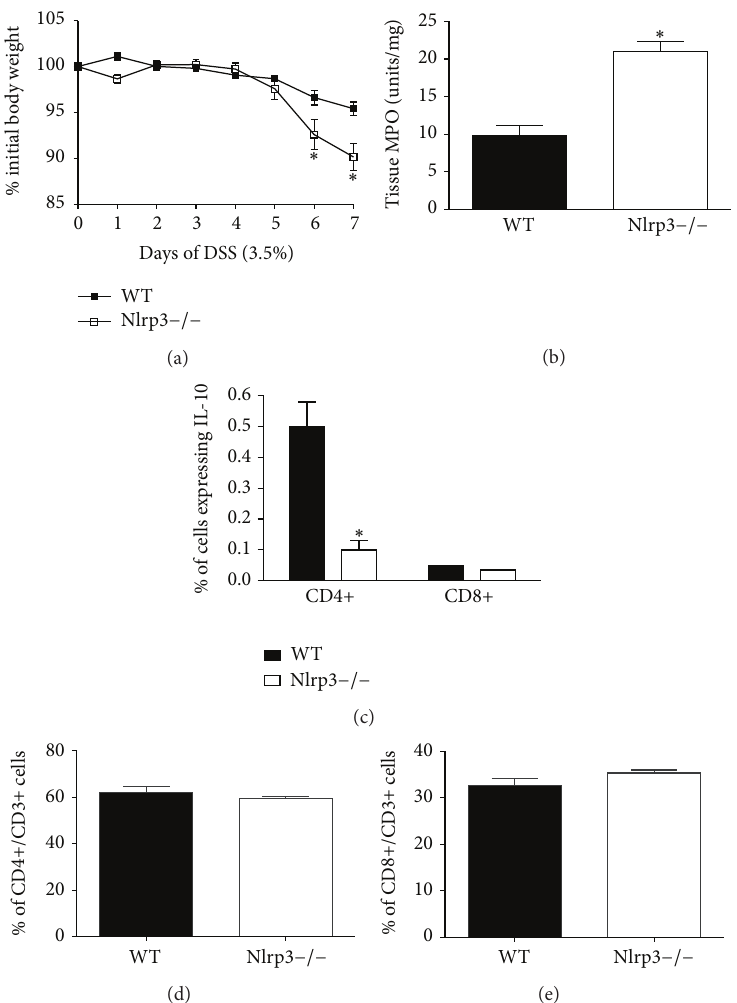
Figure 1: Nlrp3 − / − mice exhibit enhanced susceptibility to DSS-induced colitis, a phenotype that associated with reduced IL-10 expression. (a) Changes in body weight during a 7-day course of DSS (3.5% w/v in drinking water) in WT and Nlrp3 − / − mice. ∗ denotes 𝑝 < 0.05 compared to WT; 𝑛 = 6 /group. (b) Colonic tissue myeloperoxidase (MPO) levels assessed in WT and Nlrp3 − / − mice on day 7 of DSS. ∗ denotes 𝑝 < 0.05 compared to WT mice; 𝑛 = 6 /group. (c) Flow cytometric analysis of IL-10 expression in CD4+ and CD8+ T cells from the LP of WT and Nlrp3 − / − mice on day 7 of DSS. ∗ denotes 𝑝 < 0.05 compared to WT mice; 𝑛 = 6 /group. (d) Flow cytometric analysis of total CD4+/CD3+ and (e) CD8+/CD4+ cells isolated from the LP of WT and Nlrp3 − / − mice on day 7 of DSS; 𝑛 = 6